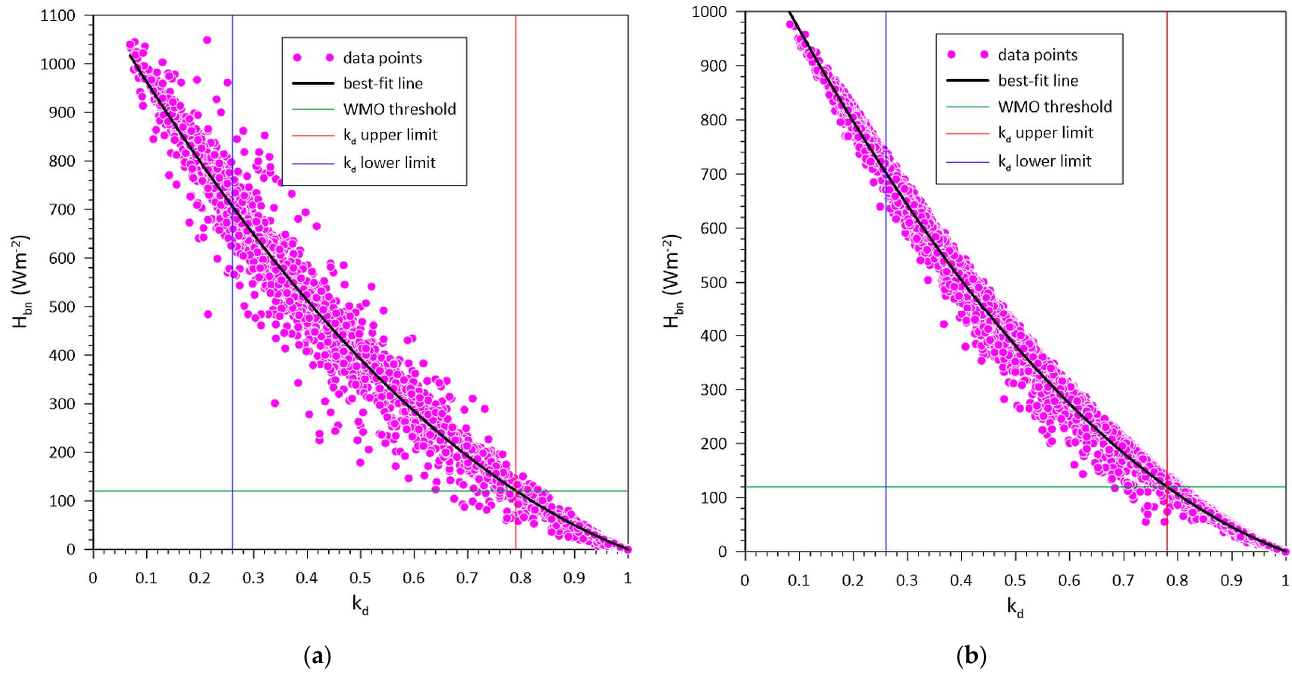
Figure 9. Determination of the k du (red line) and k dl (blue line) values for the ( a ) PAY and ( b ) REG sites.